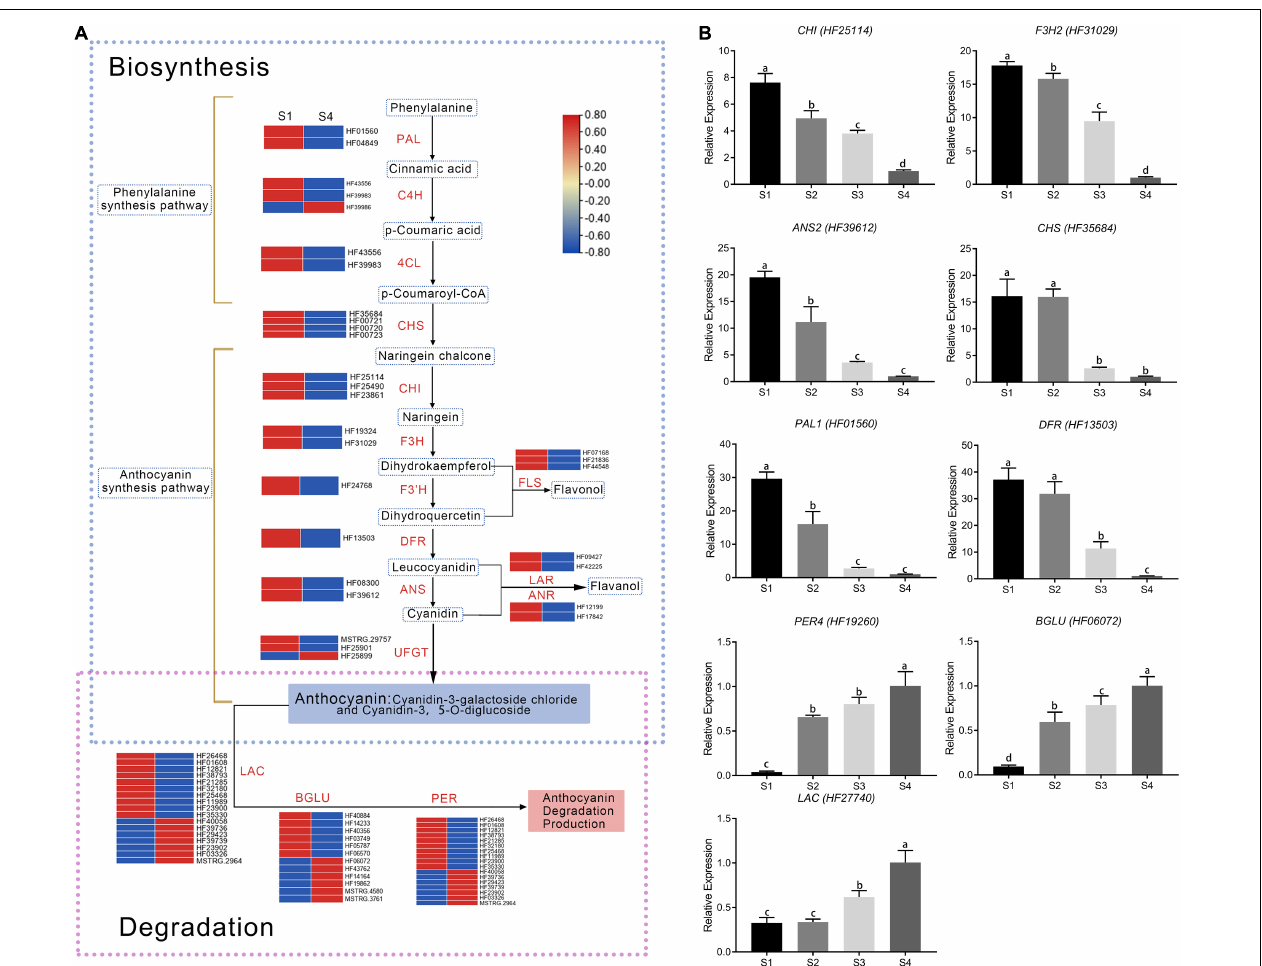
FIGURE 3 | Expression of differentially expressed genes involved in anthocyanin pathways. (A) Expression analysis of flavonoid pathway genes at S1 and S4 stages in fruit. Expression was evaluated via RNA-seq with three biological replicates. Log 2 fold change represents expression. (B) Validation of RNA-seq expression profiles in stages S1–S4 via real-time quantitative RT-PCR. Values were calculated relative to the transcription level in S4 (set to one). Error bars represent the standard errors. Different lowercase letters indicate significant differences among treatments according to one-way ANOVA test ( P <